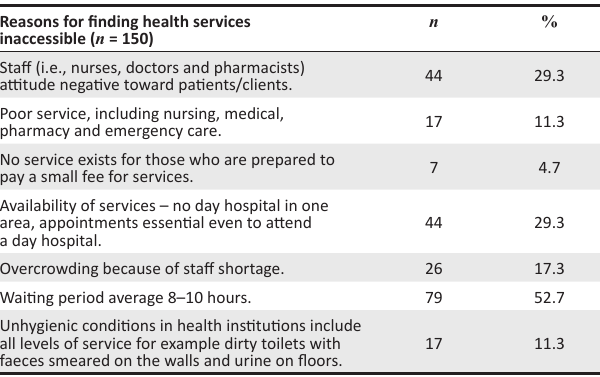
TABLE 4b: Reasons for finding health services inaccessible ( n =